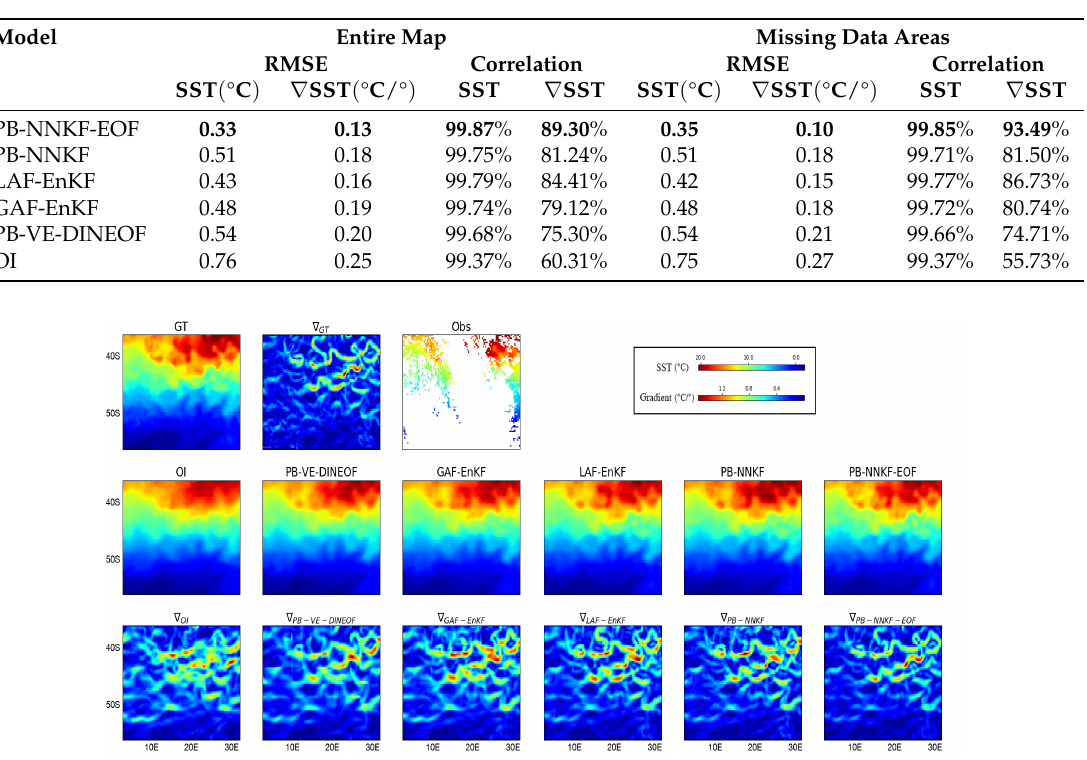
Table 3. SST interpolation experiment: Reconstruction correlation coefficient and RMSE over the SST time series and their gradient.